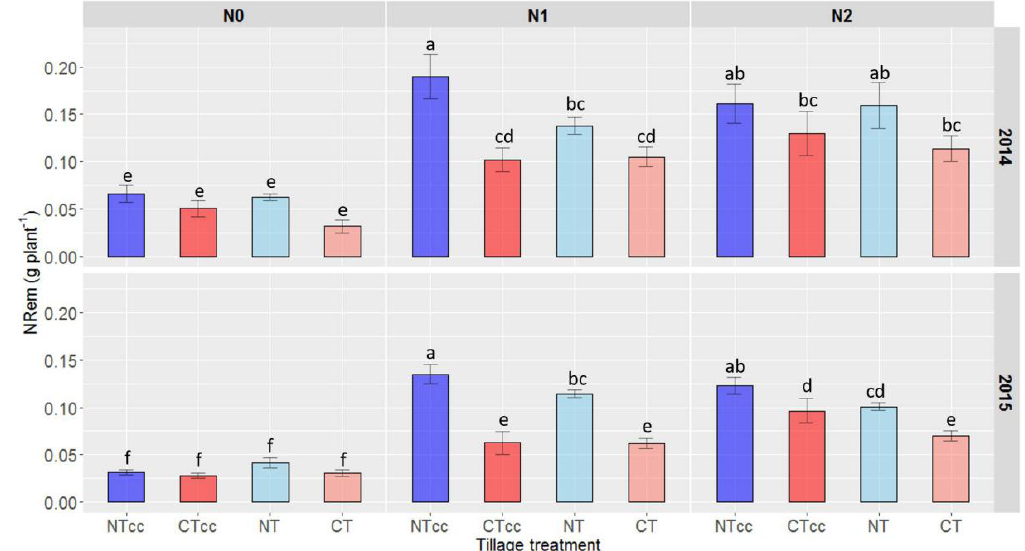
Figure 3. Impact of tillage treatment, cover crops and N application on NRem of wheat grown in 2014 and 2015. NTcc: No-till with cover crops. NT: No-till without cover crops. CTcc: Conventional tillage with cover crops. CT: Conventional tillage without cover crops. N0: no added N fertilization. N1: 161 kg N ha −1 . N2: 215 kg N ha −1 . Soil tillage practices (CT and NT) and N fertilization (N0, N1 and N2)